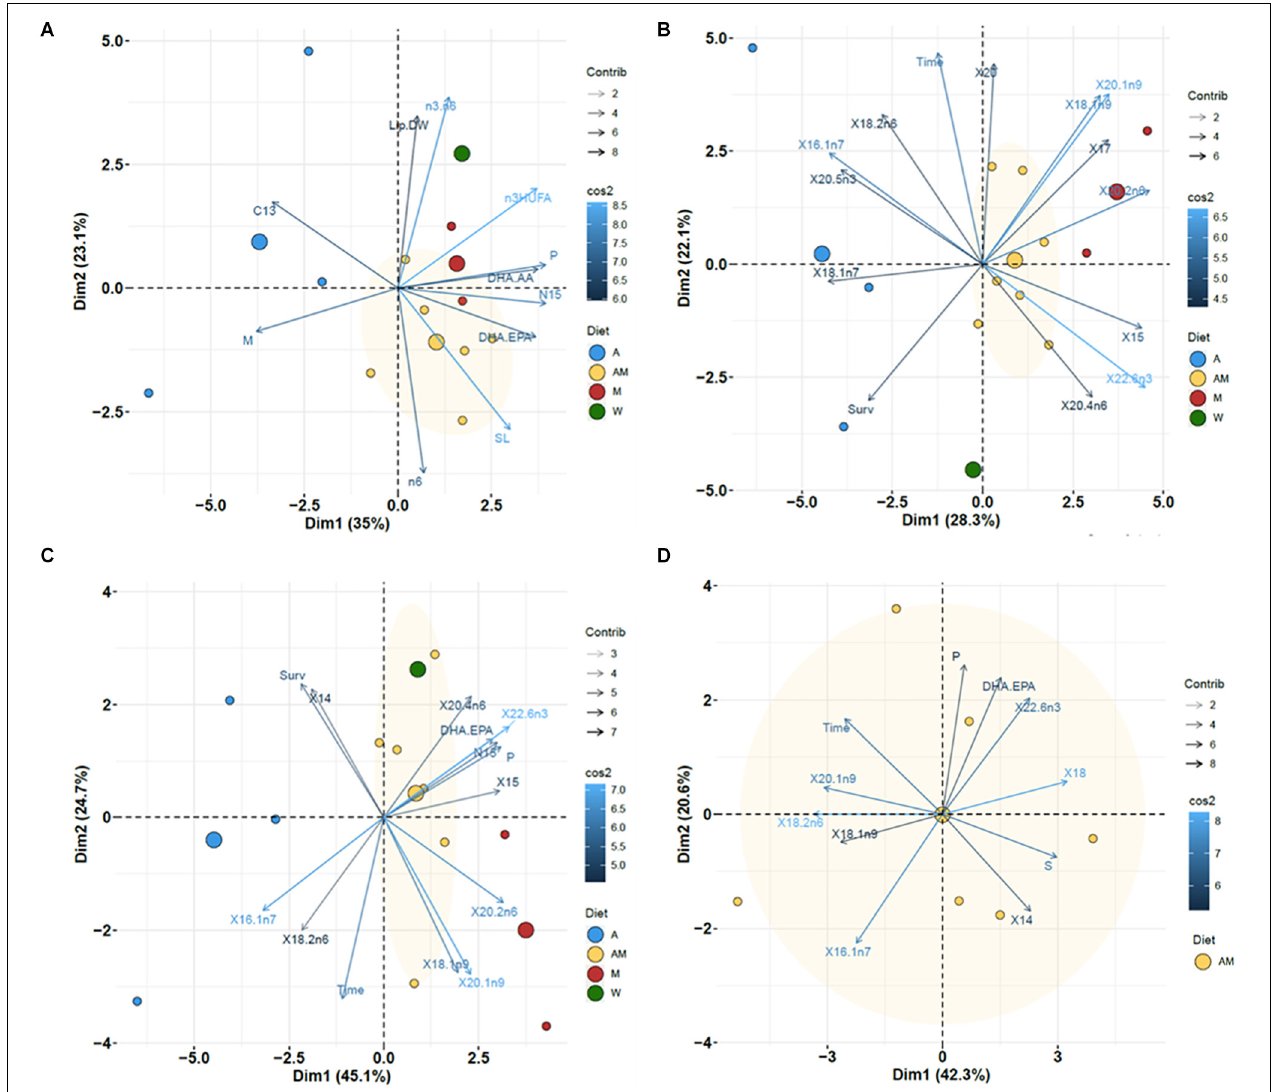
FIGURE 4 | Factor score plots for the principal component analysis (PCA) on newborn seahorses released by wild (W) or cultivated (A, AM, and M) adults. Only the variables with the highest contributions (cos2 > 0.6) on factors 1 and 2 maps are shown. Analyses performed on datasets (A) – all diets and general characteristics of newborn, (B) – all diets and all individual FA, (C) – all diets and variables selected according to K-M and J–T test, and (D) – diet AM (Same as for C ). Original variable names were automatically modified by R software. Variables: days elapsed since the onset of the breeding period (Time), SL, W, Survival at 7 DAR (Surv), total C (C.), total N (N.), C/N (C.N), δ 13 C (C13), δ 15 N (N15), total lipids (Lip.DW), saturated FA (S), monounsaturated FA (M), polyunsaturated FA (P), n-3 HUFA, n-3 FA, n-6 FA, n-3/n-6 (n3.n6), DHA/EPA, DHA/AA, and individual FA. The ellipse corresponding to 95% confidence for group AM is shown in yellow shadow. Other ellipses were not computed due to insufficient